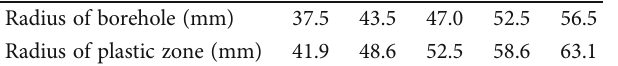
Table 3: Calculated radii of the plastic zone of boreholes with di ff erent pore